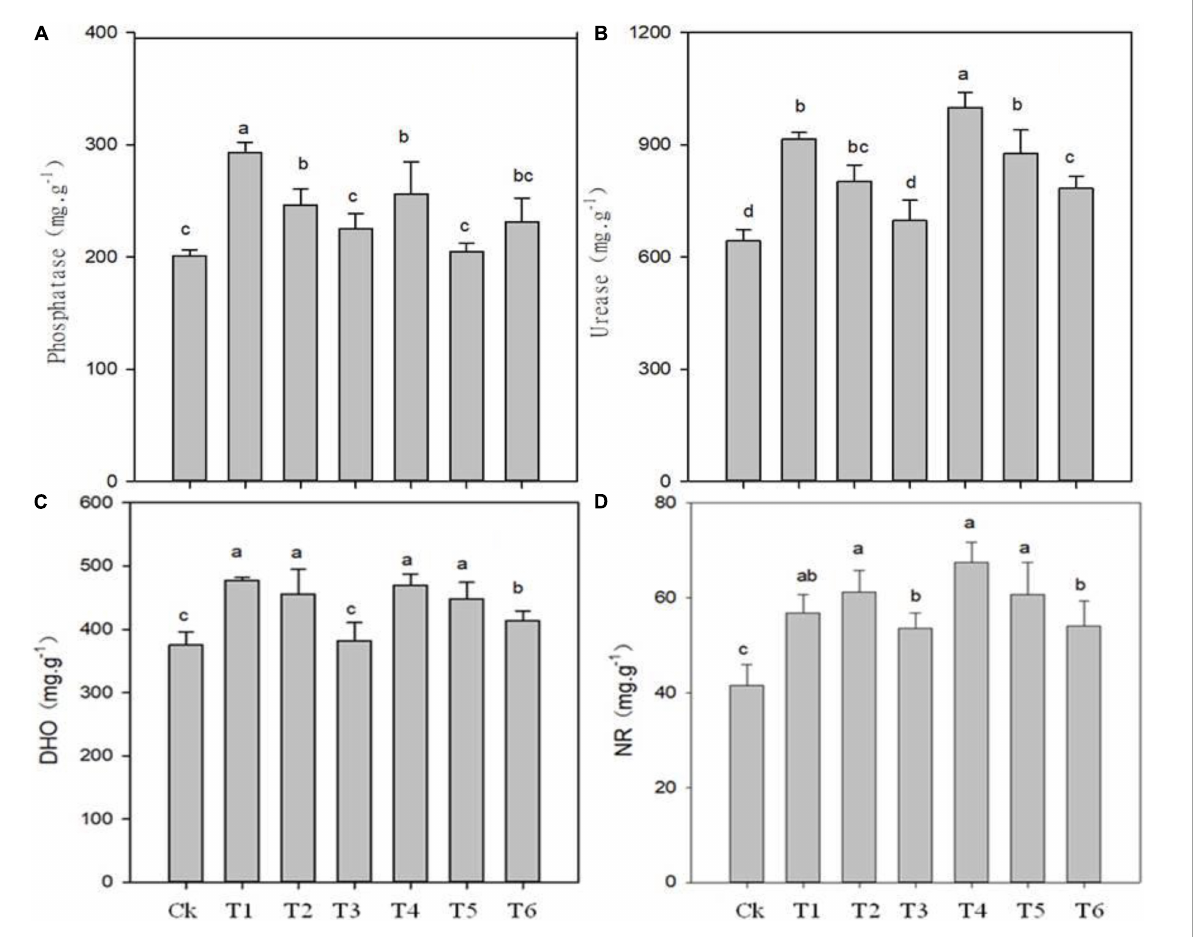
FIGURE1 Effects of biochar, organic-inorganic and mixed fertilizer on the soil phosphate (A) , urease (B) , dehydrogenase (DHO) (C) and nitrate reductase (NR) activities (D) . Different letters (a, b, and c) above the columns and curve indicate statistical significance at p < 0.05.